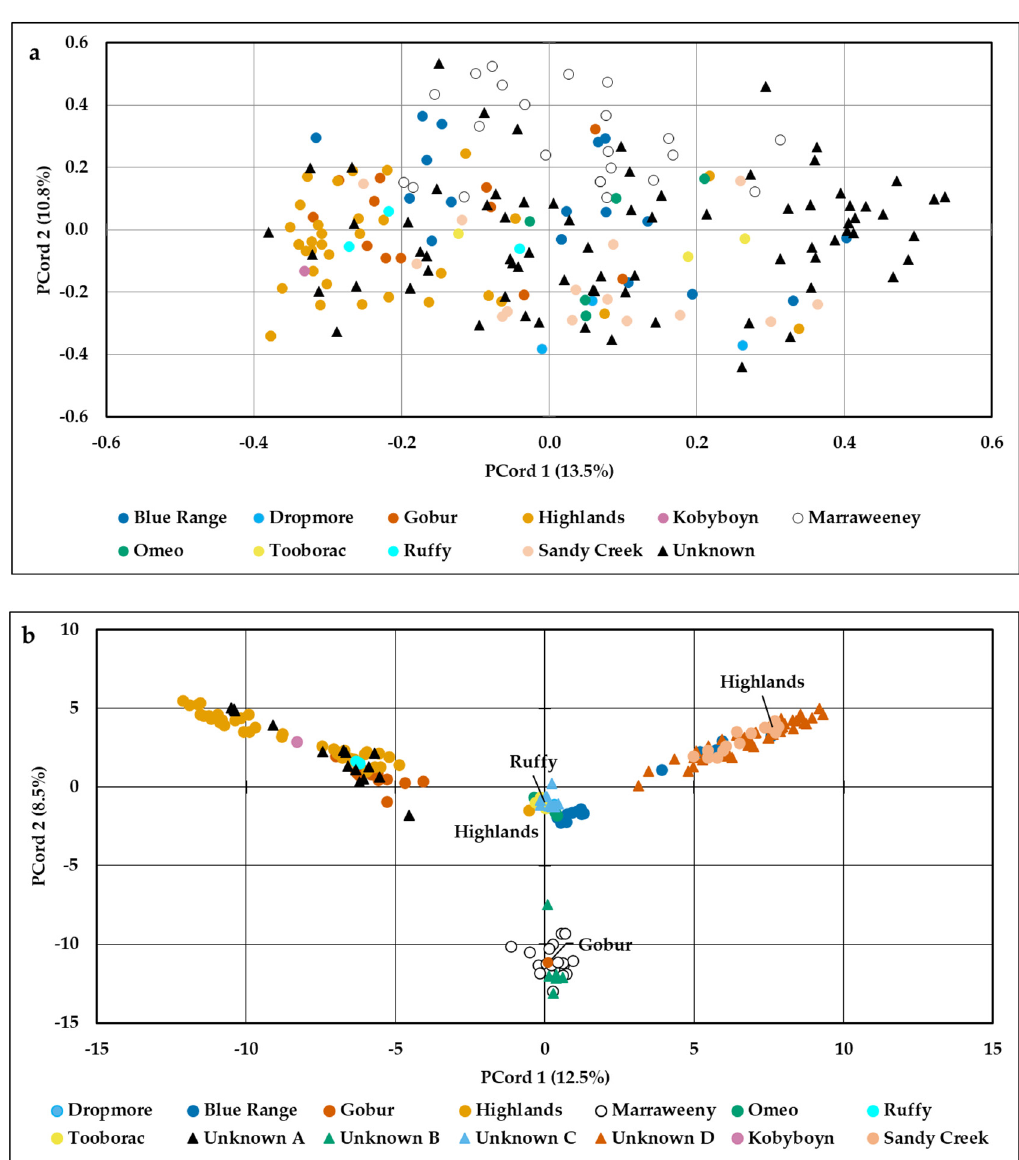
Figure 4. Principal coordinates analysis results for all Banksia marginata trees based on ( a ) SSR and ( b ) SNP datasets.